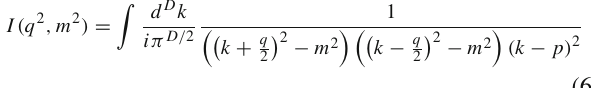
It is well known that the scalings coming from bottom facets are the regions which are required for the asymptotic expansion of the Feynman integrals in the given